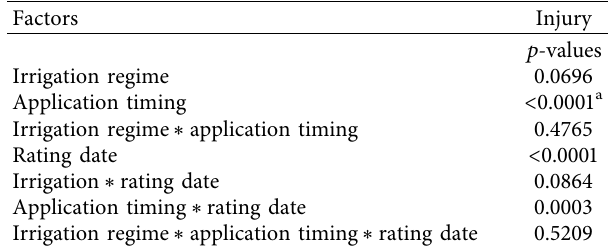
a p -values at or smaller than 0.05 level considered